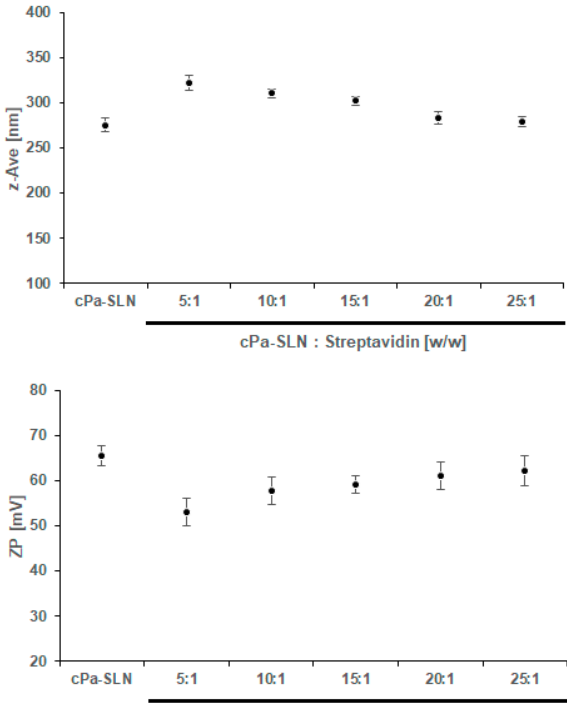
Figure 4. Variation on the mean particle size (z-Ave, upper panel) and zeta potential (ZP, lower panel) of c Pa -SLN- S complexes obtained from different c Pa -SLN—Streptavidin binding ratios. Results are given as a mean from three measurements of three independent experiments.